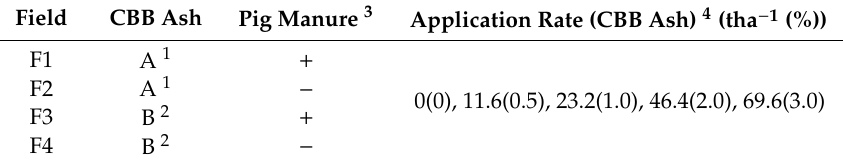
Table 2. Soil amendments and application rate in the experimental fields